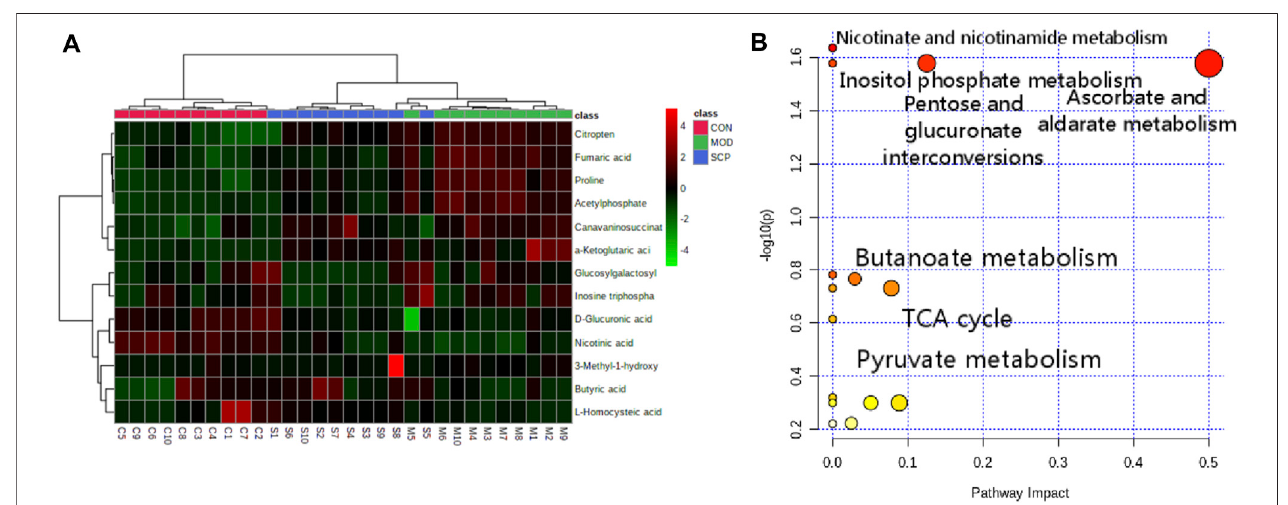
FIGURE 8 | Heat map of potential biomarker changes (A) and pathways in SCP-treated rats (B) .